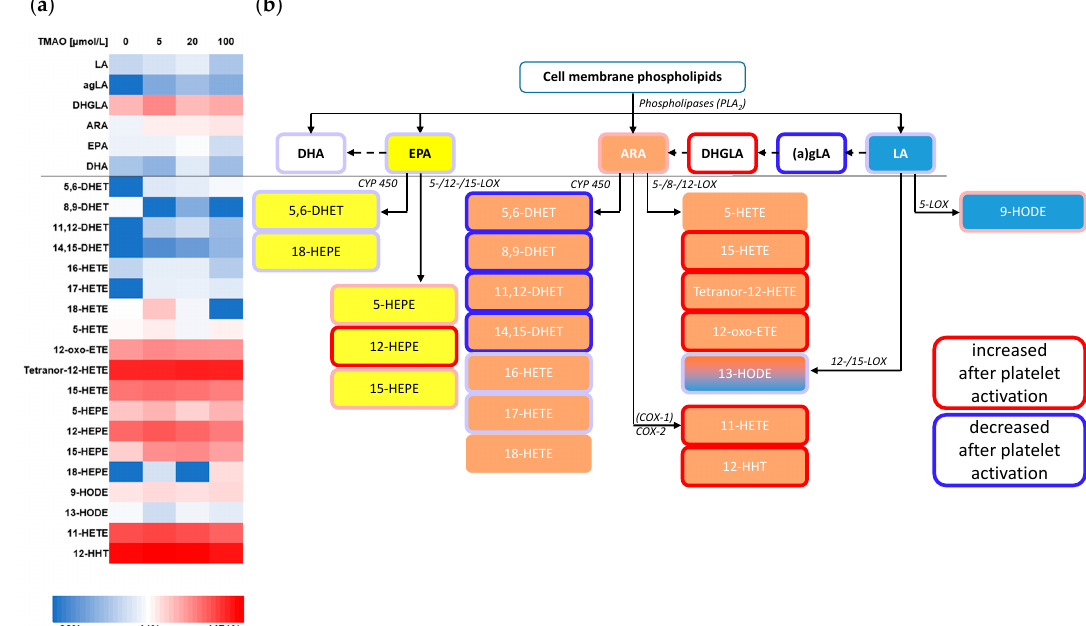
Figure 4. ( a ) Concentration-changes of eicosanoids after platelet activation with ristocetin at different TMAO-concentrations in relation to before activation. ( b ) Pathway classification of the quantified PUFA metabolites after platelet activation, including the most relevant enzyme classes. Concentration changes are marked using frames (red – increased, blue – decreased). The horizontal black line sepa- rates precursor fatty acids from metabolic products. TMAO indicates trimethylamine-N-oxide; a/gLA, α / γ -linolenic acid; ARA, arachidonic acid; COX, cyclooxygenase; DHA, docosahexaenoic acid; DHET, dihydroxy-eicosatrienoic acid; DHGLA, dihomo- γ -linolenic acid; EPA, eicosapentaenoic acid; ETE, eicosatetraenoic acid; HEPE, hydroxy-eicosapentaenoic acid; HETE, hydroxyl-eicosatetraenoic acid; HHT, hydroxy-heptadecatrienoic acid HODE, hydroxyl-octadecadienoic acid; LA, linoleic acid; LOX, lipoxygenase; PLA2, phospholipase